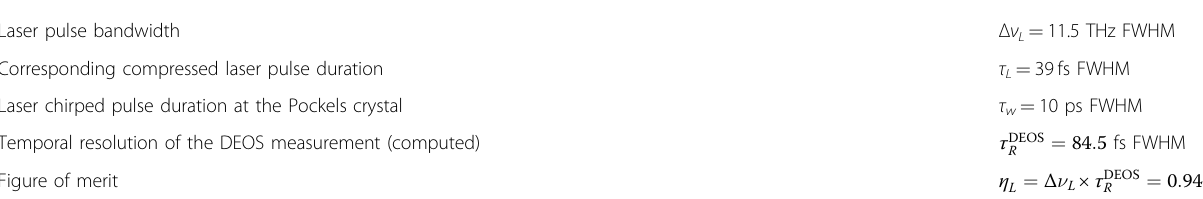
Table 2 Example of expected time resolution limitation (numerical simulation) due to the fi nite laser bandwidth (i.e., an in fi nitely fast crystal is assumed).